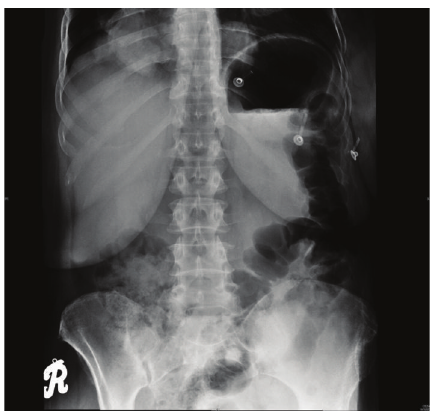
Figure 1: Plain abdominal radiograph showing dilatation of small bowel without any gas-fluid levels.